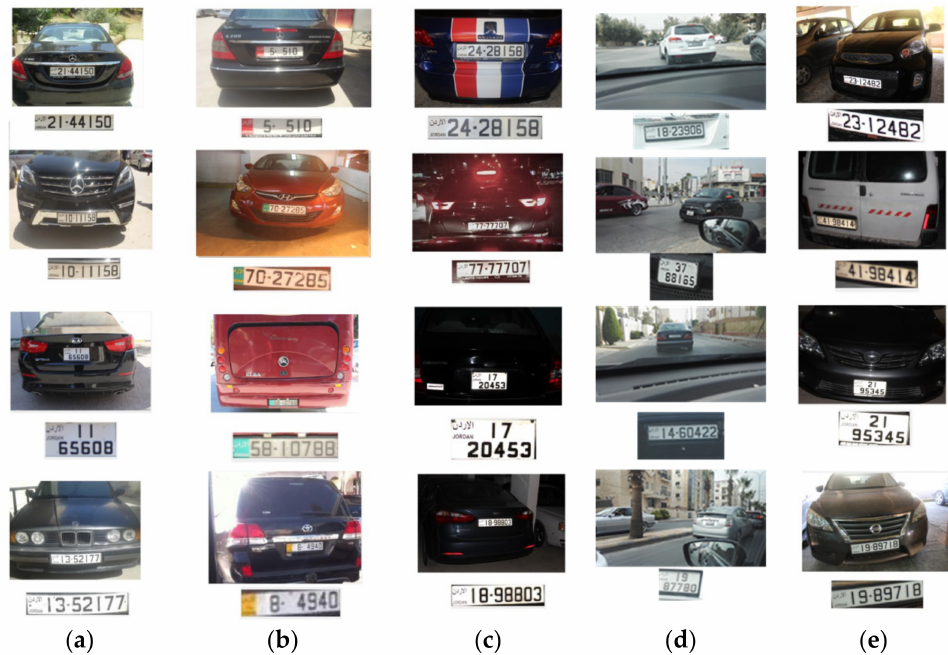
Figure 2. Samples of the collected dataset elements, taken at/for: ( a ) a sunny day, ( b ) different vehicles’ categories, ( c ) different lighting conditions, ( d ) vehicles in movement, and ( e ) different tilt